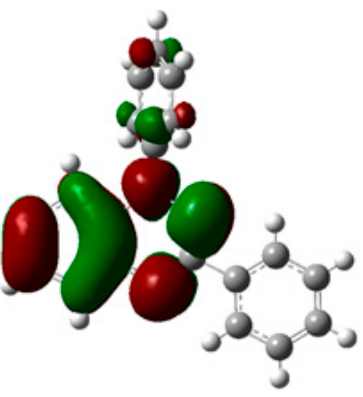
Figure 1. SOMO of Blatter radical 1 calculated at the UB3LYP/6-311+G(d,p).